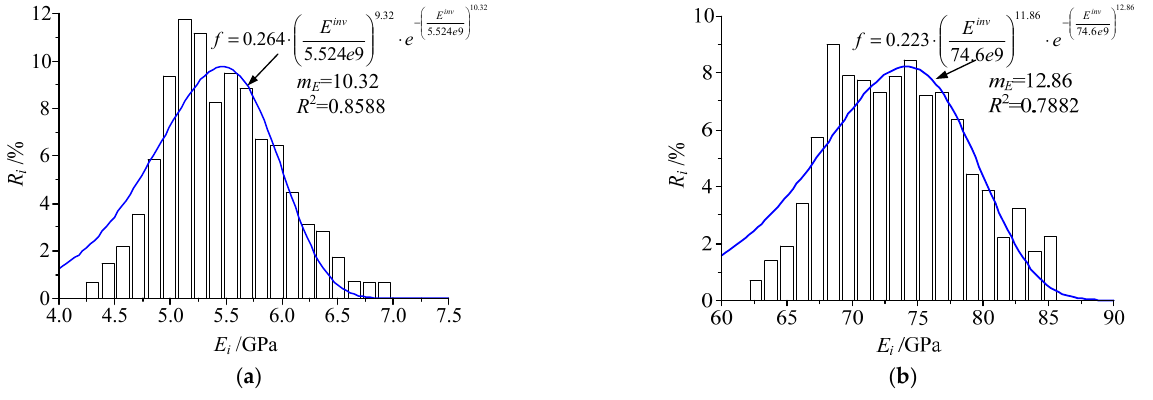
Figure 9. Statistical distribution of micro Young’s modulus of ( a ) sandstone and ( b ) aluminum.